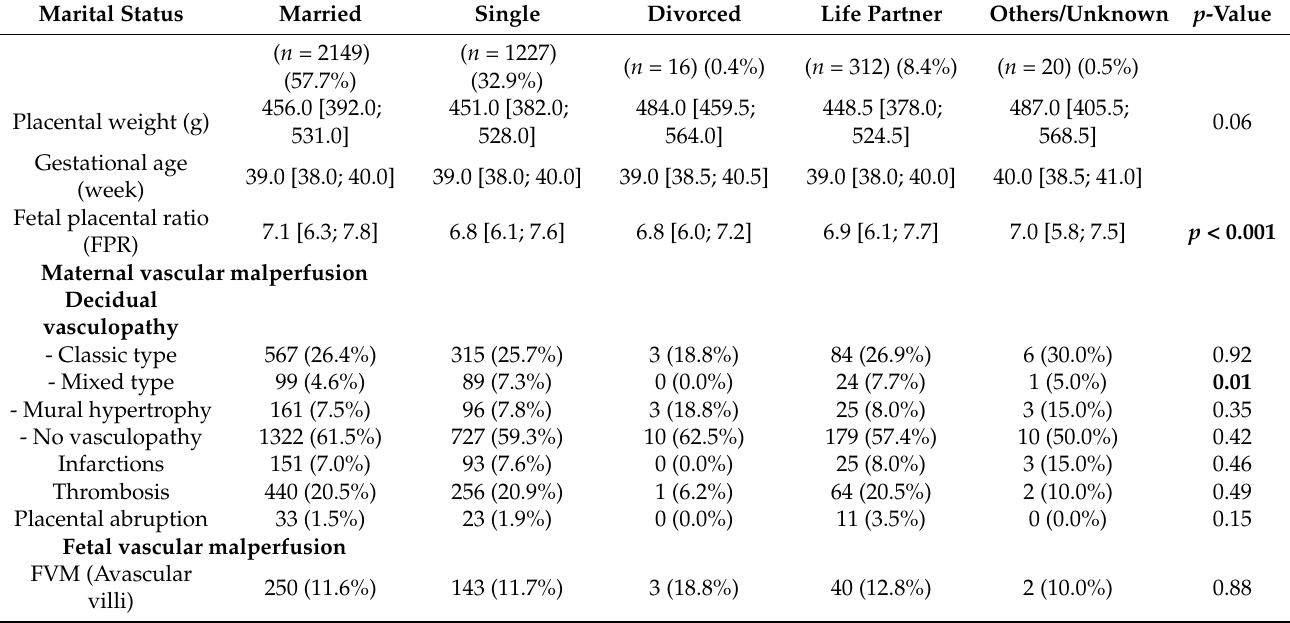
Table 2. Marital status and placental